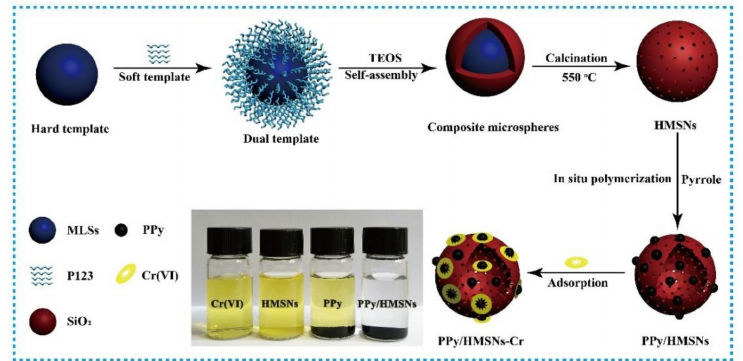
Figure 1. The preparation flow chart of polypyrrole / hollow mesoporous silica particles (PPy / HMSNs) and the adsorption e ff ect for Cr(VI), and photographs of an aqueous solution of Cr(VI) before and after mixing with hollow mesoporous silica particles (HMSNs), polypyrrole (PPy), and PPy /